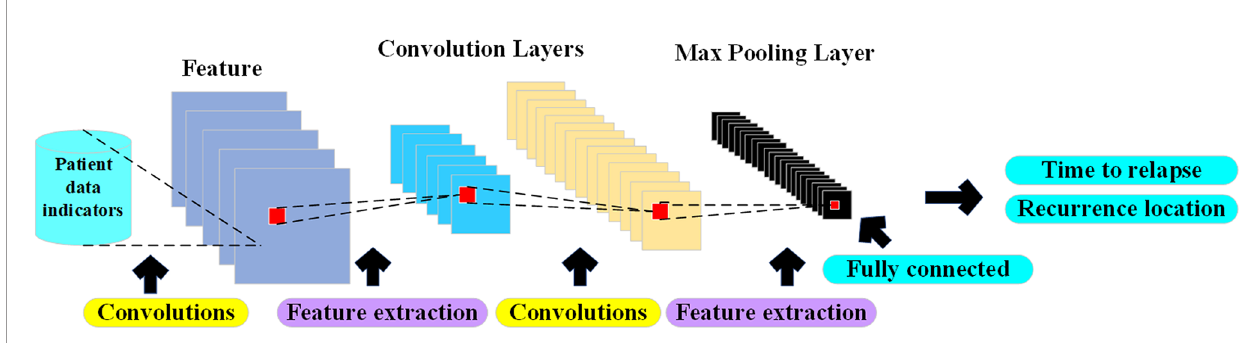
FIGURE 2 | Auxiliary diagnosis CNN structure